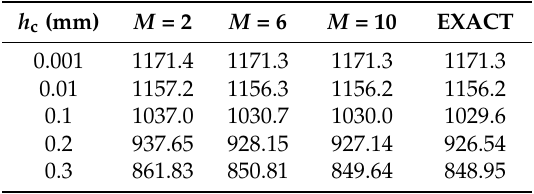
Table 5. Temperature at the interfacial point (0.5 mm, 1 mm) for different coating thicknesses for linear